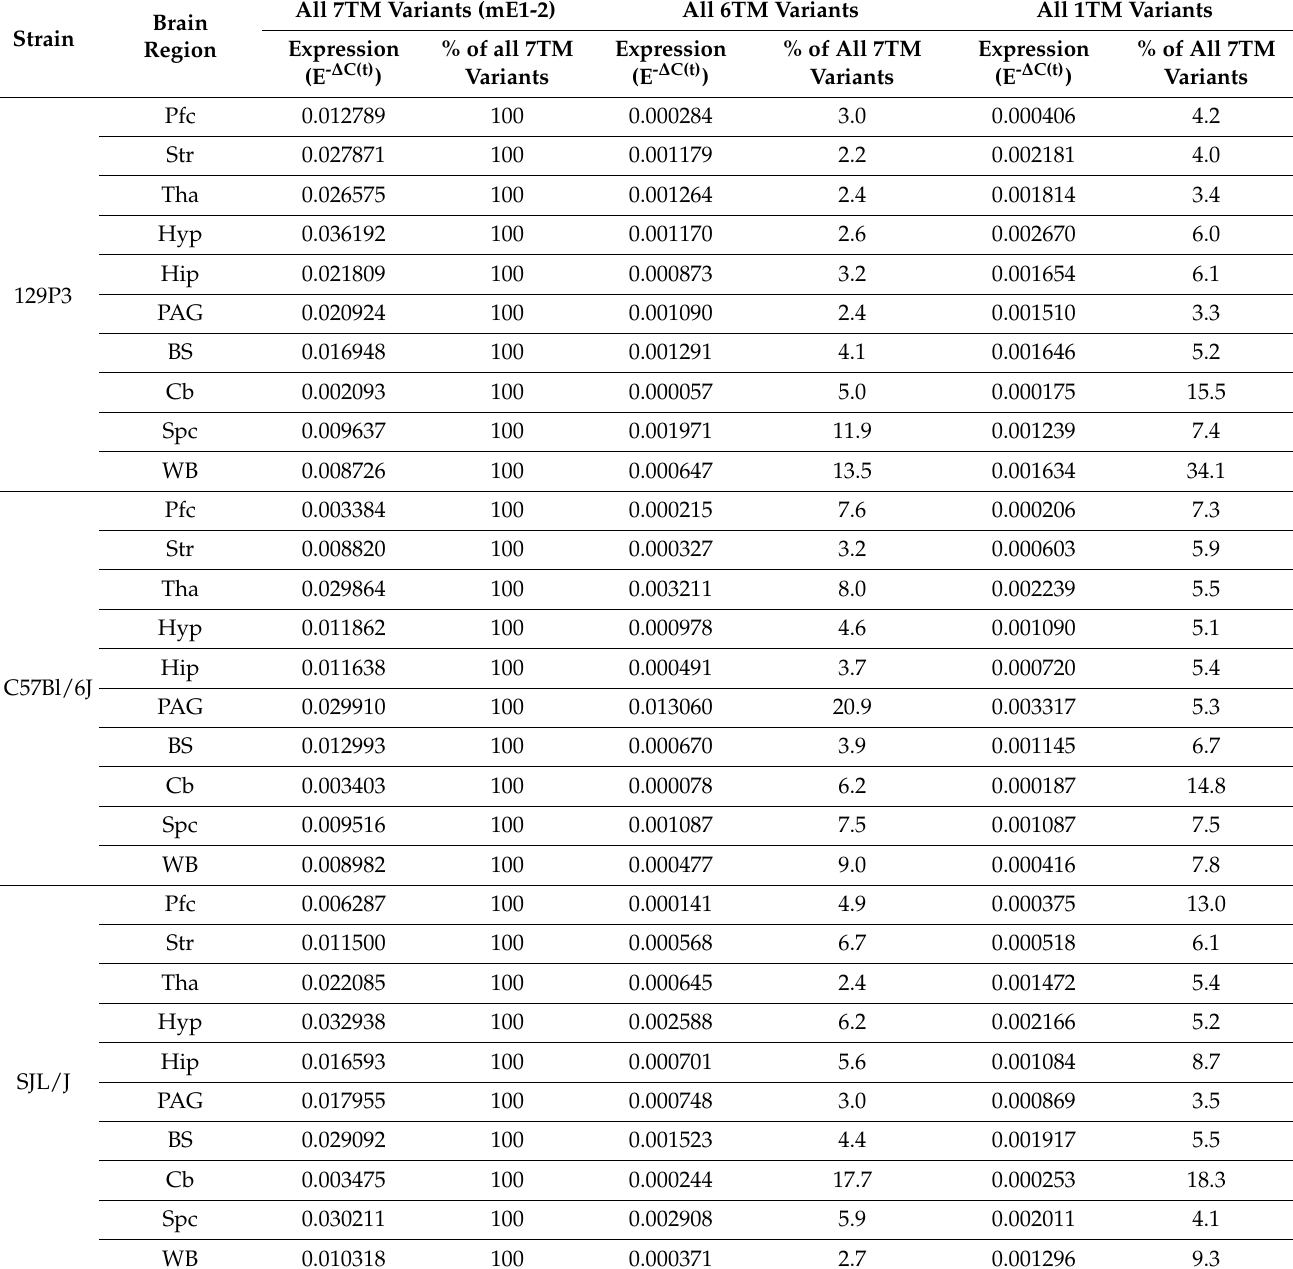
level of all 6TM variants was 20.4% of all 7TM variants, which was the highest among the brain regions and among the mouse strains. The expression level of all 1TM variants in the prefrontal cortex of SJL/J mice was higher than those in the other three mouse strains. These results further demonstrated region-specific and strain-specific alternative splicing of the Oprm1 gene. Table 3. mRNA expression levels of all 7TM, 6TM, and 1TM splice variants in brain regions of four inbred mouse strains. Strain